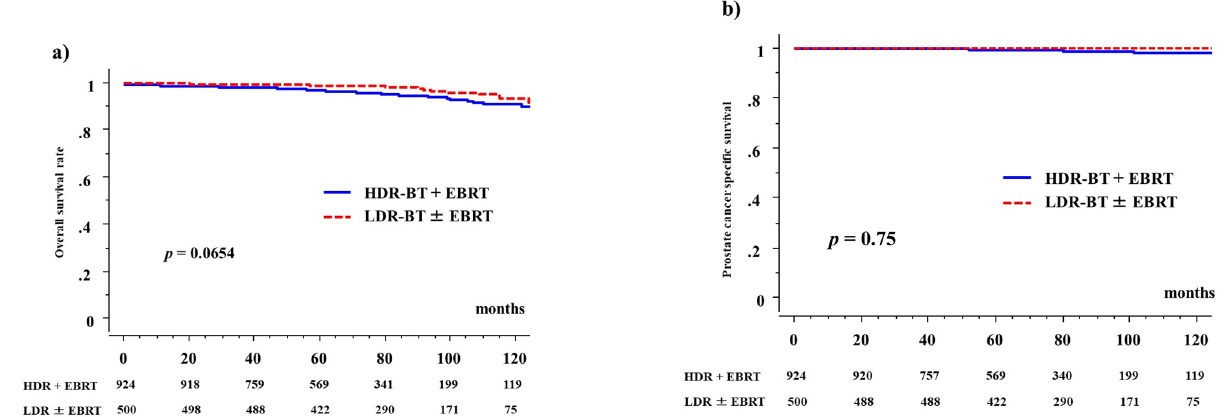
Figure 4. Overall and prostate cancer specific survival rate between HDR-BT with EBRT and LDR-BT with or without EBRT. ( a ) Overall survival rate. ( b ) Prostate cancer specific survival rate.